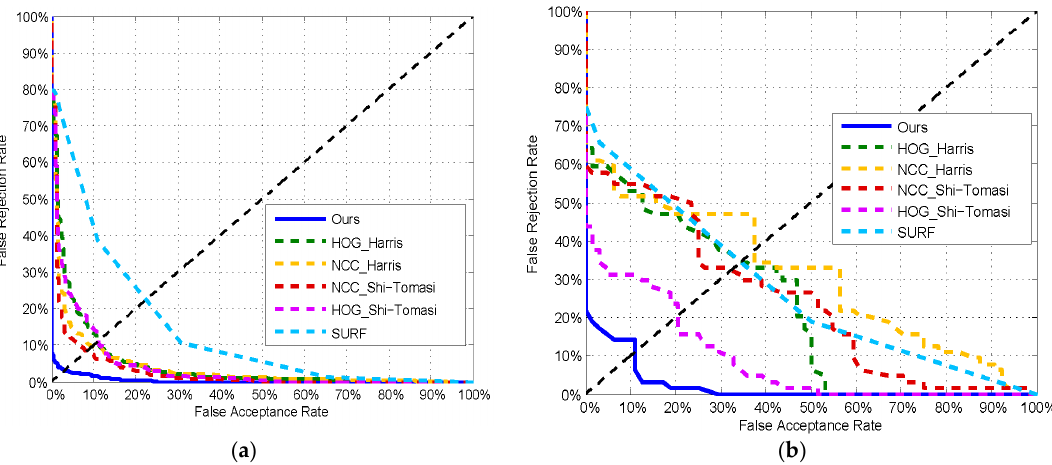
Figure 11. The receiver operating characteristics (ROC) curves of different methods on the datasets. ( a ) ROC curves on the MUES-SV1KR2R dataset; ( b ) ROC curves on the MUES-SV2HS2S dataset.